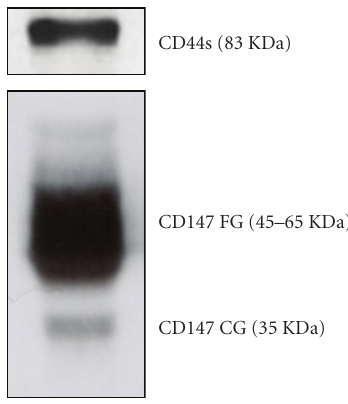
Figure 1: Western-blot for CD44 (breast cancer cell line MDA MB 231) and CD147 (human colon tissue). The protein molecular weights observed are in accordance with the predicted for these proteins. FG: fully glycosylated, CG: core